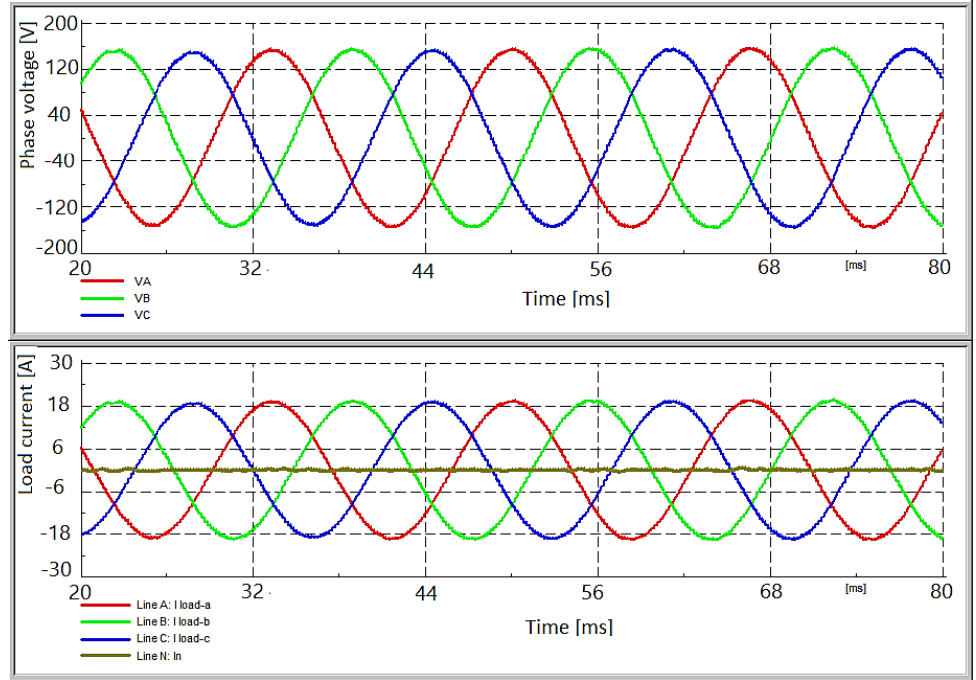
Figure 14. Output three-phase voltages and currents for the balanced load.